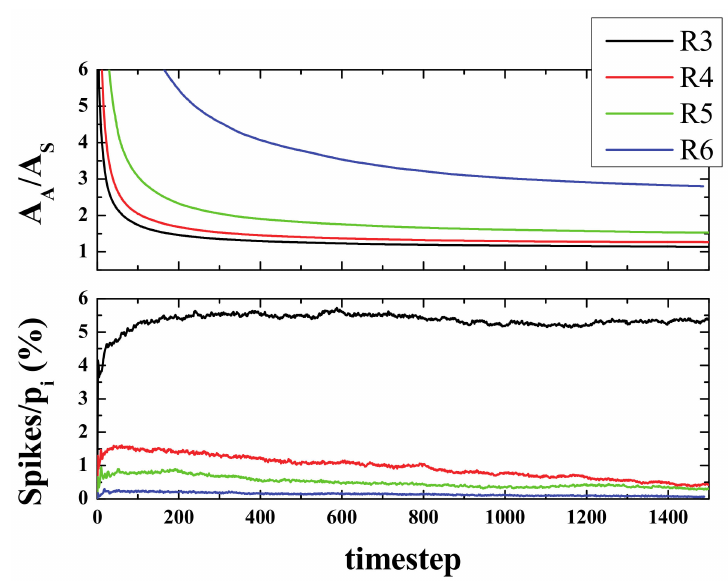
Figure 7. (Color online) Top panel: Ratio between the activated area and the spiked area, A A /A S vs. time. Bottom panel: Number of spikes divided by the total initial population (i.e., 200,000), as a percentage of